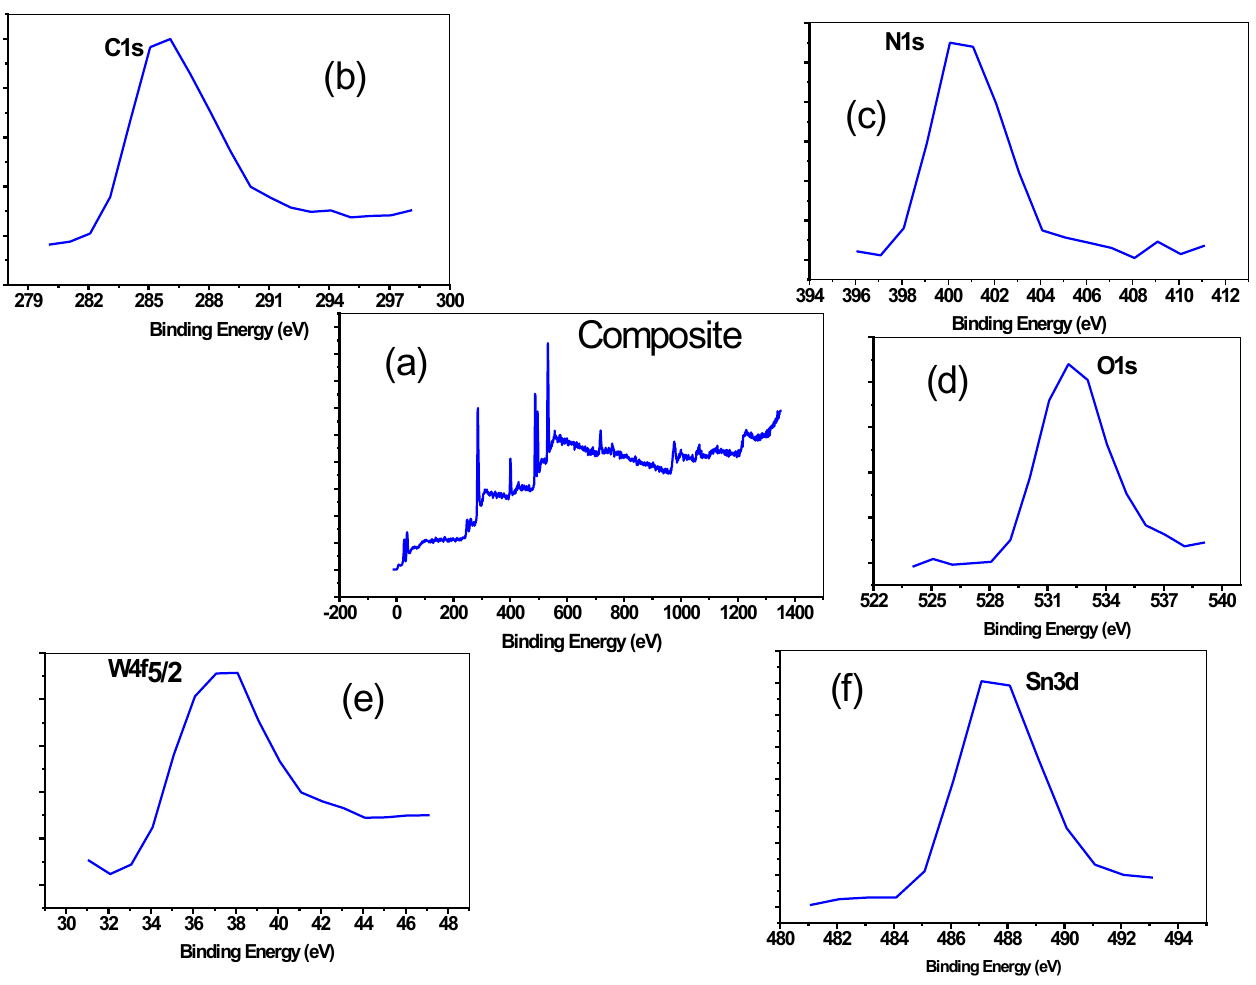
Figure 4. X-ray photoelectron spectroscopy (XPS) study of the PNMPy/nano-Stannous(II)SiO 3 composite showing different peaks for different metals in ( a ) for composite, ( b ) carbon, ( c ) nitrogen, ( d ) oxygen, ( e ) tungsten, and ( f ) for Tin.